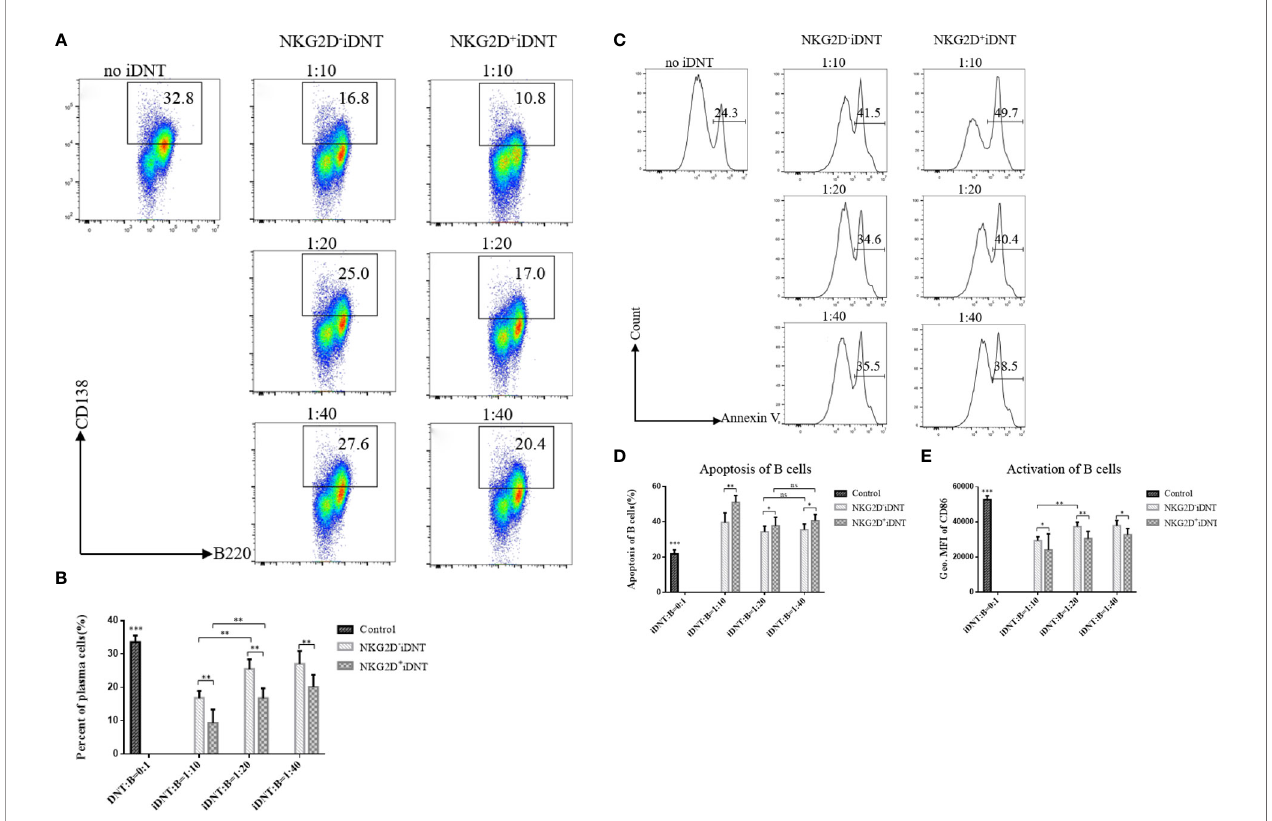
FIGURE 4 | NKG2D enhances iDNT cell-mediated inhibition of B cell differentiation into plasma cells in vitro . Freshly sorted TCR ab + CD3 + CD4 - CD8 - NKG2D + or TCR ab + CD3 + CD4 - CD8 - NKG2D - iDNT cells were incubated with naïve B cells at a gradient ratio of 0.4×10 5 , 0.2×10 5 or 0.1×10 5 iDNT cells to 4×10 5 B cells in 96- well round-bottom plates in B cell medium for 2 days. LPS (10 m g/mL) was added to the medium, and we analyzed the activation, differentiation and apoptosis of B cells. (A) Representative fl ow cytometry pro fi les of B cell differentiation into plasma cells in vitro . (B) The bar graphs are representative of three independent B-cell differentiation experiments. (C) Histograms are representative of B cell apoptosis at different ratios. (D) The bar graphs are representative of three independent B-cell apoptosis experiments. (E) The bar graphs are representative of three independent B-cell activation experiments. Student ’ s t -test was used to compare two independent variables (ns, not signi fi cant, * p < 0.05, ** p < 0.01, and *** p <